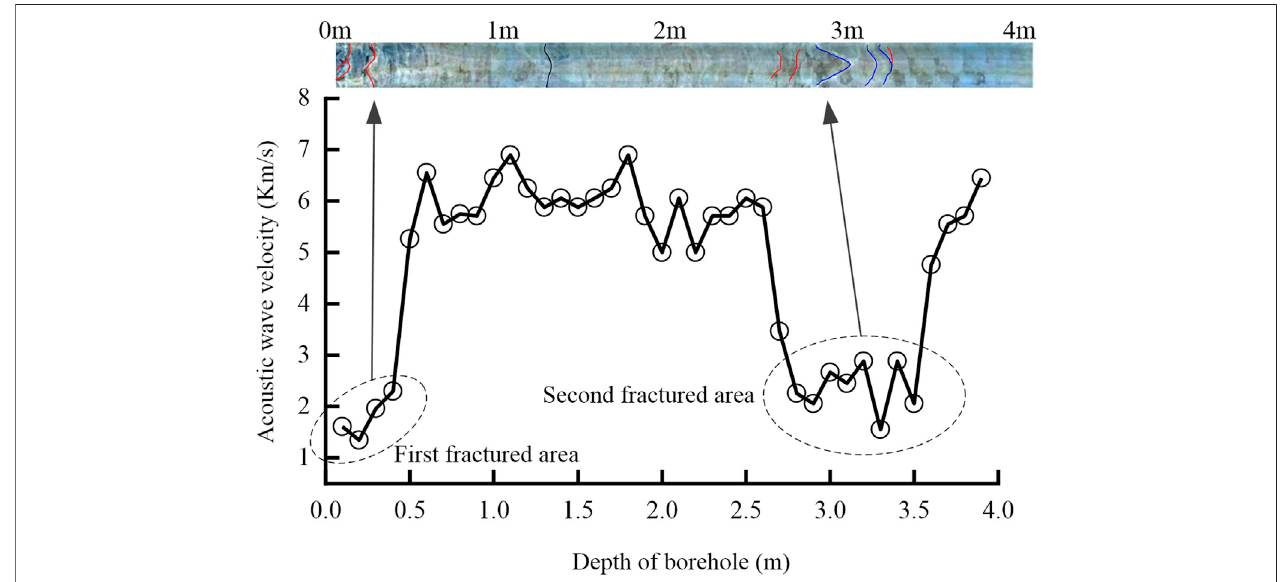
FIGURE 3 | Test in area with several fractured